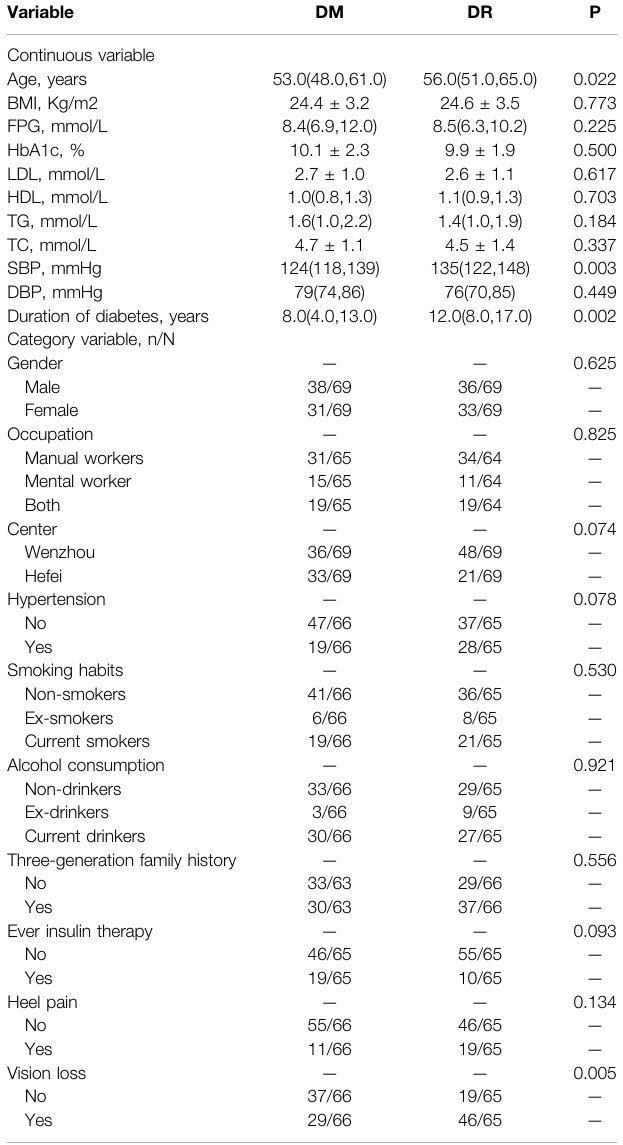
TABLE 1 | Demographics and clinical indicators of participants included in the